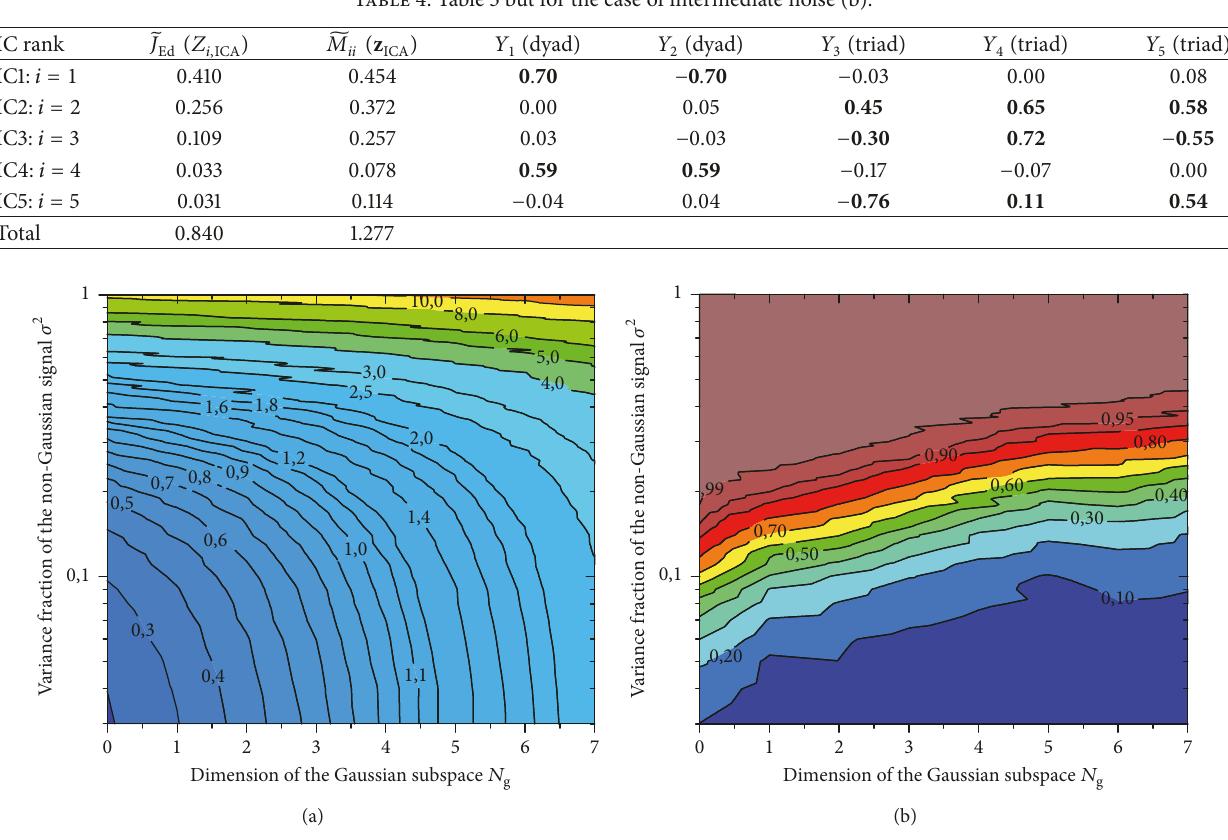
̃𝐽 ( y ) as a function of 𝜎 2 and 𝑁 Ed = 99 % (1% significance level) as a function of 𝜎 2 and 𝑁 sig